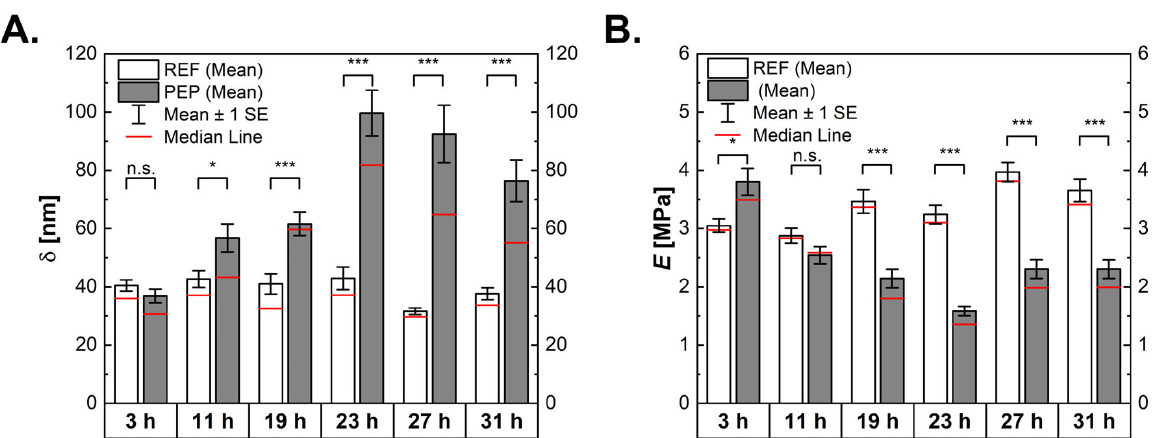
Figure 5. Elastic properties of bacteria shown as indentation ( A ) and apparent Young’s modulus ( B ). The number of measured cells over 3 to 31 h for the reference cells was 76, 55, 42, 51, 51 and 54 and for the peptide-producing cells it was 54, 51, 50, 75, 60 and 57. N.s. indicates non-statistically significant differences, * significance with with p -value < 0.01 and *** with p -value < 0.001.